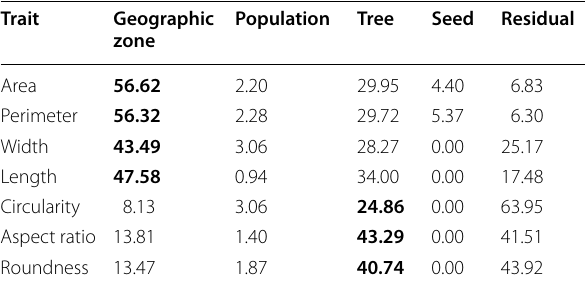
Table 2 Estimated percentage variance across hierarchical levels